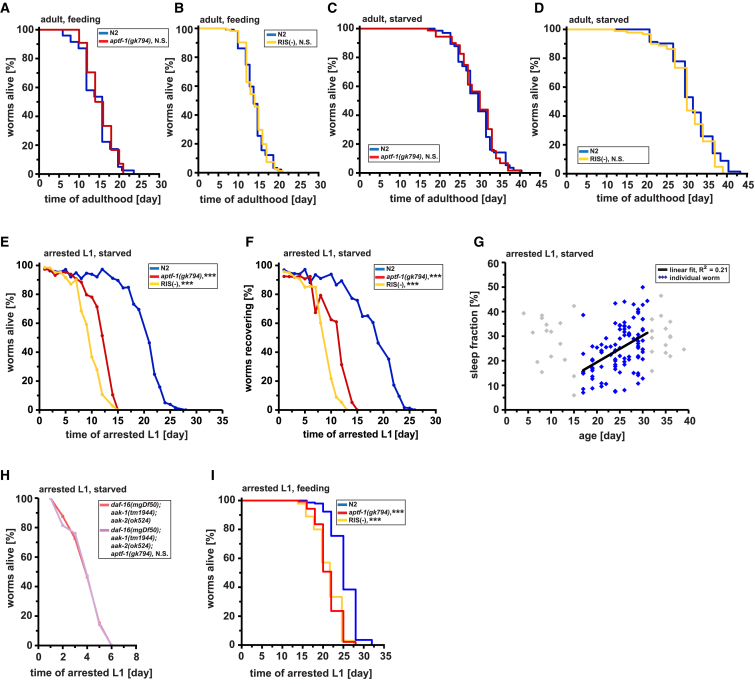
Sleep Is Required for Surviving Larval Starvation-Induced ArrestShown are representative experiments; additional replicates can be found in Figure S5.(A) Adult lifespans of feeding wild-type (blue) and aptf-1(gk794) (red) worms were not significantly different (mean lifespan, N2: 14.6 days, n = 44 worms; aptf-1(gk794): 15.3 days, n = 43 worms; p = 0.71; log rank test).(B) Lifespan of feeding wild-type (blue) and RIS(−) (yellow) adult worms shows no significant difference (mean lifespan, N2: 14.2 days, n = 94 worms; RIS(−): 14.1 days, n = 86 worms; p = 0.71; log rank test).(C and D) No significant difference of lifespan was detected in (C) starved adult aptf-1(gk794) compared to starved N2 (mean lifespan, N2: 29.8 days, n = 60 worms; aptf-1(gk794): 29.5 days, n = 63 worms; p = 0.65; log rank test) and (D) also not in starved RIS(−) (mean lifespan N2: 32.0 days, n = 85 worms; RIS(−): 30.6 days, n = 84 worms; p = 0.06; log rank test).(E) L1-arrested aptf-1(gk794) mutants and RIS ablated worms showed substantially reduced survival in the absence of food (time at which 50% of worms were still alive, N2: 20.7 days, n > 60 worms for each time point; aptf-1(gk794): 12.1 days, n > 60 worms; ∗∗∗p < 0.001; RIS(−): 9.4 days, n > 60 worms; ∗∗∗p < 0.001; significance shown from day 8; Fischer’s exact test).(F) Arrested L1 aptf-1(gk794) and RIS-ablated worms showed a significant decline in the ability to re-enter development when fed (time at which 50% of worms were still able to recover, N2: 18.7 days, n > 60 worms; aptf-1(gk794): 11.4 days, n > 60 worms; ∗∗∗p < 0.001; RIS(−): 8.5 days, n > 60 worms; ∗∗∗p < 0.001; significance shown from day 8 for RIS(−) and day 10 for aptf-1 mutant; Fischer’s exact test).(G) Sleep amount predicts starvation survival. Arrested starved L1 larvae were cultured in microchambers, and their sleep and survival were quantified. Data from individual worms within the range used for linear fitting (black line) are plotted as blue diamonds (data outside the range of the SD of the mean, including early-dying immobile individuals, were excluded; gray); R2 = 0.21.(H) Starved arrested L1 aak-1(tm1944)/aak-2(ok524)/daf-16(mgDf50)/aptf-1(gk794) quadruple mutants showed no reduced survival compared to aak-1(tm1944)/aak-2(ok524)/daf-16(mgDf50) triple mutants (time at which 50% of worms were still alive, aak-1(tm1944)/aak-2(ok524)/daf-16(mgDf50): 3.9 days, n > 60 worms; aak-1(tm1944)/aak-2(ok524)/daf-16(mgDf50)/aptf-1(gk794): 3.9 days, n > 60 worms; p > 0.05 for all days; Fischer’s exact test).(I) FUdR-arrested L1s in the presence of food have a decreased survival. Arrested L1 survival is significantly decreased in aptf-1(gk794) and in RIS(−) worms (mean survival, N2: 25.7 days, n = 143 worms; aptf-1(gk794): 21.9 days, n = 140 worms; ∗∗∗p < 0.001; RIS(−): 22.1 days, n = 135 worms; ∗∗∗p < 0.001; log rank test).See also Figures S5 and S6 and Tables S1, S2, S3, S4, and S5 for additional replicates and details on food consumption.